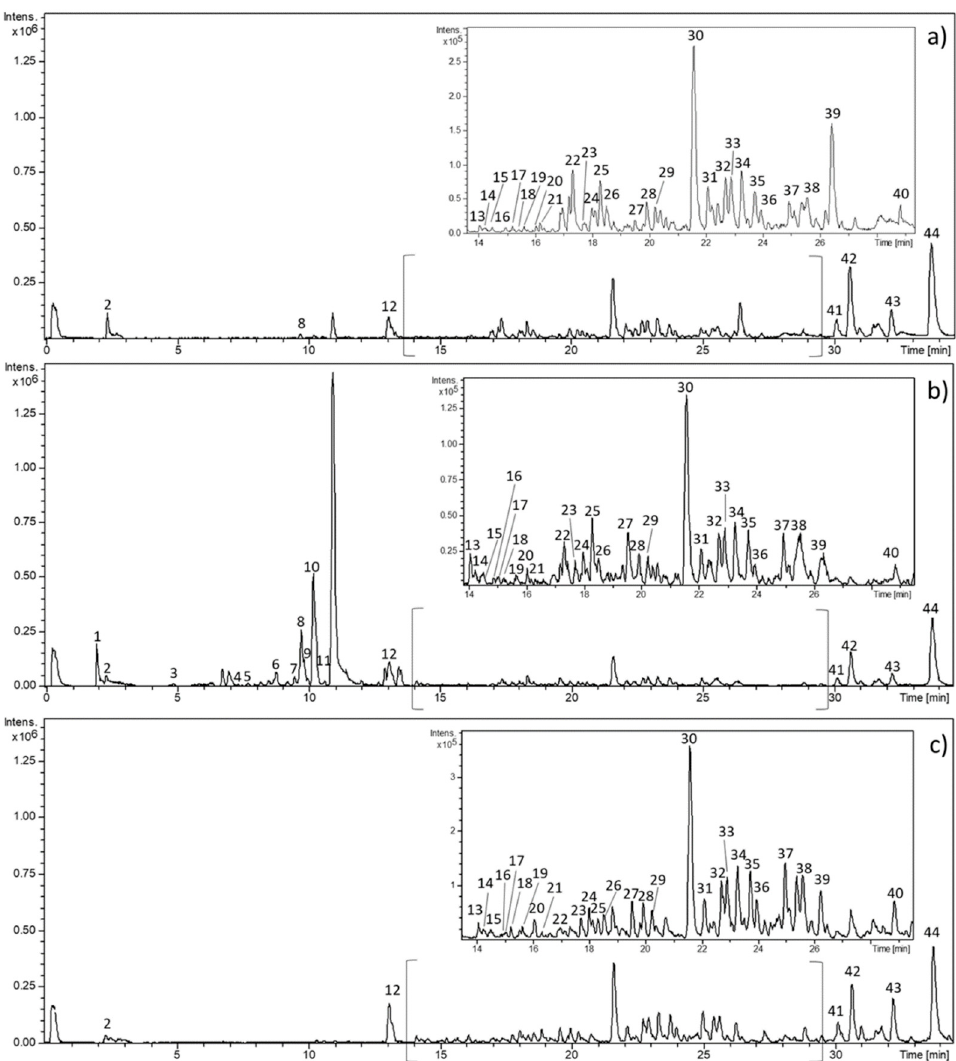
Figure 1. Base peak chromatogram of representative maceration (M 13) ( a ), pressurized liquid (PLE) (PLE 5) ( b ), and supercritical fluid (SFE) (SFE 1) ( c ) extracts obtained by high-performance liquid chromatography coupled with electrospray time-of-flight mass spectrometry